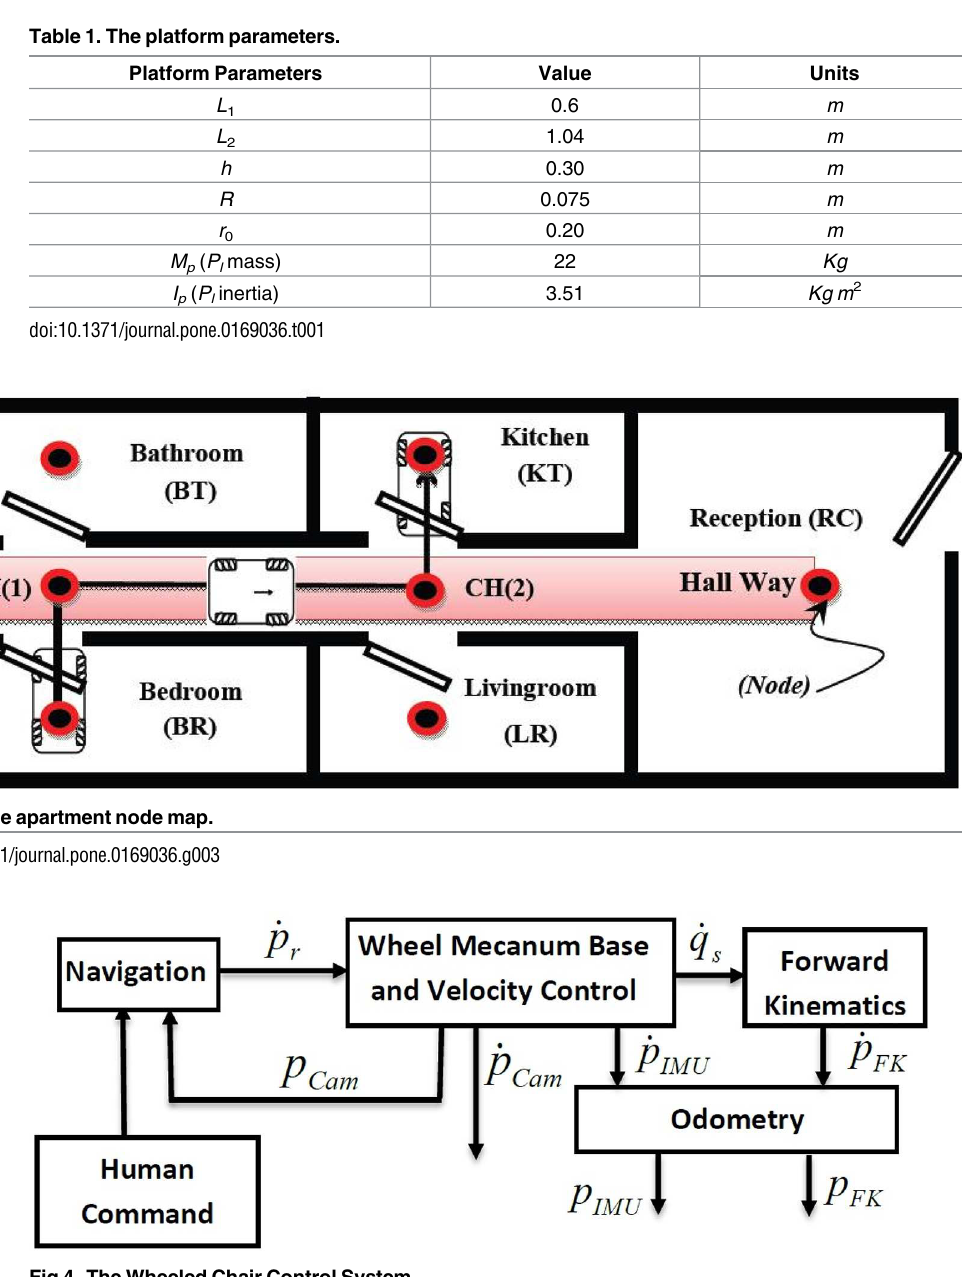
Fig 4. The Wheeled Chair Control